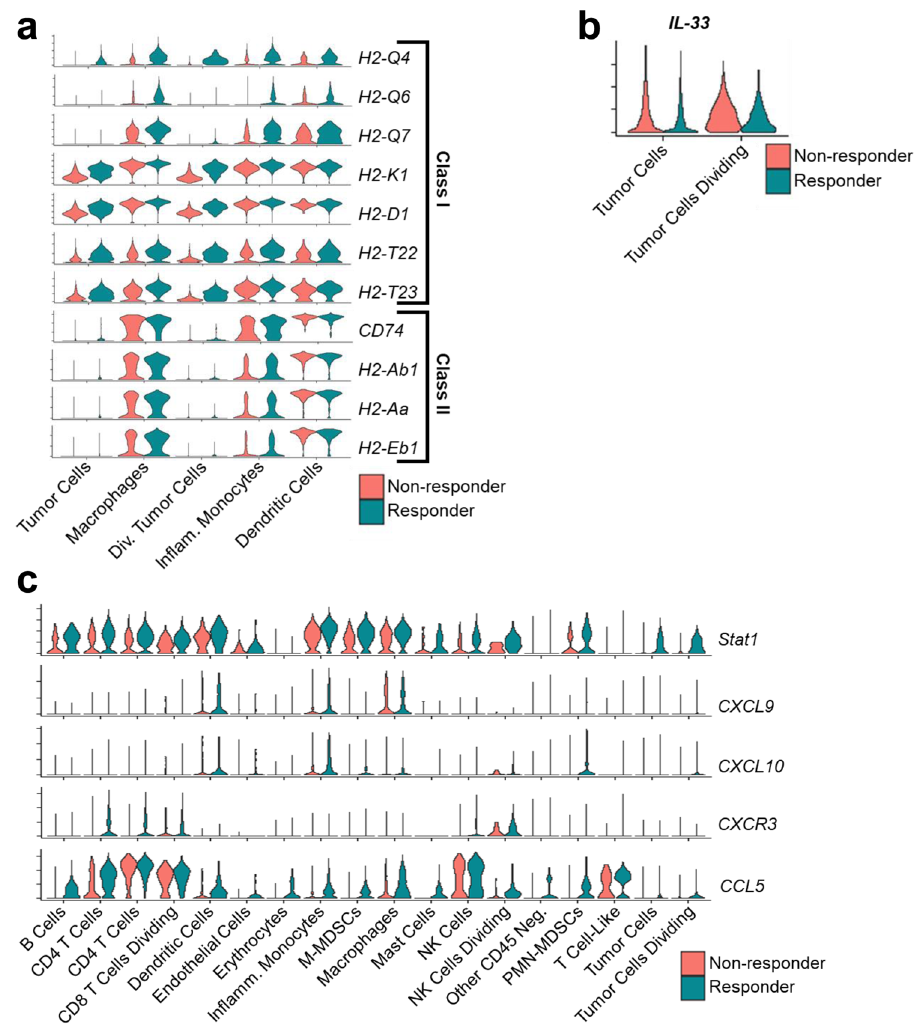
Fig. 6 Bintrafusp alfa responders have elevated MHC-I and MHC-II expression, and chemokine expression consistent with antitumor immunity. a Violin plots showing MHC-I and MHC-II subunit expression in the indicated UMAP clusters in A223 tumors responding (blue) and not responding (red) to bintrafusp alfa treatment. b Violin plots showing IL-33 expression in both A223 tumor cells and dividing tumor cells, separated by their responder (blue: responder, red: nonresponder) status. c Violin plots showing Stat1, CXCL9, CXCL10, CXCR3, and CCL5 expression in responder (blue) and nonresponder (red) tumors across all UMAP clusters. Violin plots show gene expression vertically on the y axis, and the binned cell count as the width on the x